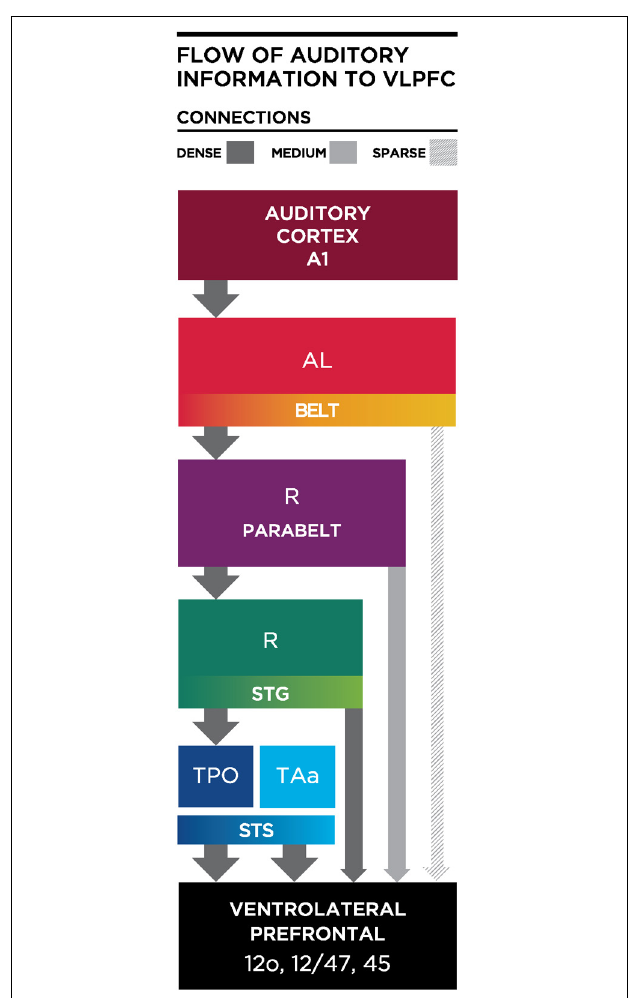
FIGURE 4 | Schematic diagram illustrating the flow of information from the auditory cortex to the VLPFC. Thick and dark gray arrows illustrate dense projections from STS, with less dense projections arriving from parabelt and lateral belt regions. AL, Antero-lateral; R, Rostral; STS, Superior Temporal Sulcus; STG, Superior Temporal Gyrus; TPO, temporal parieto-occiptal area; TAa, Temporal